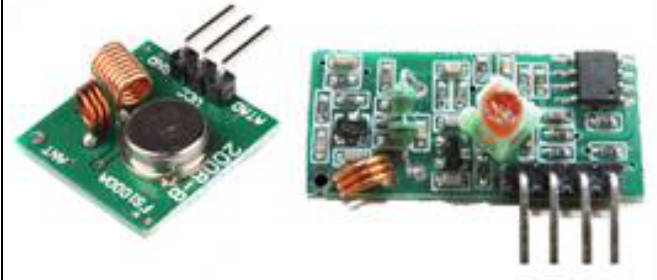
Figura 2: Módulo RF Transmissor e Receptor de 433 MHz.